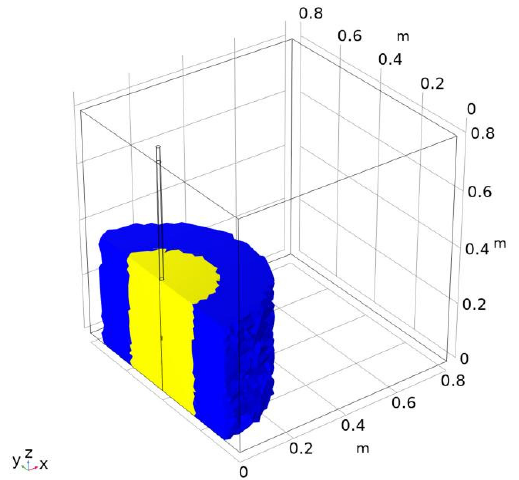
Figure 11. Comparison between the simulation results of the two grouting theoretical models; the blue and yellow colors, respectively, represent the simulation results of the grouting theoretical model without considering the displacement effect and while considering the displacement effect.